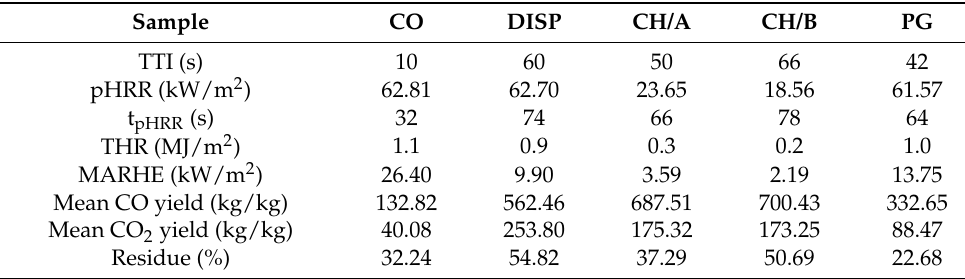
Table 3. Cone calorimeter test results of studied